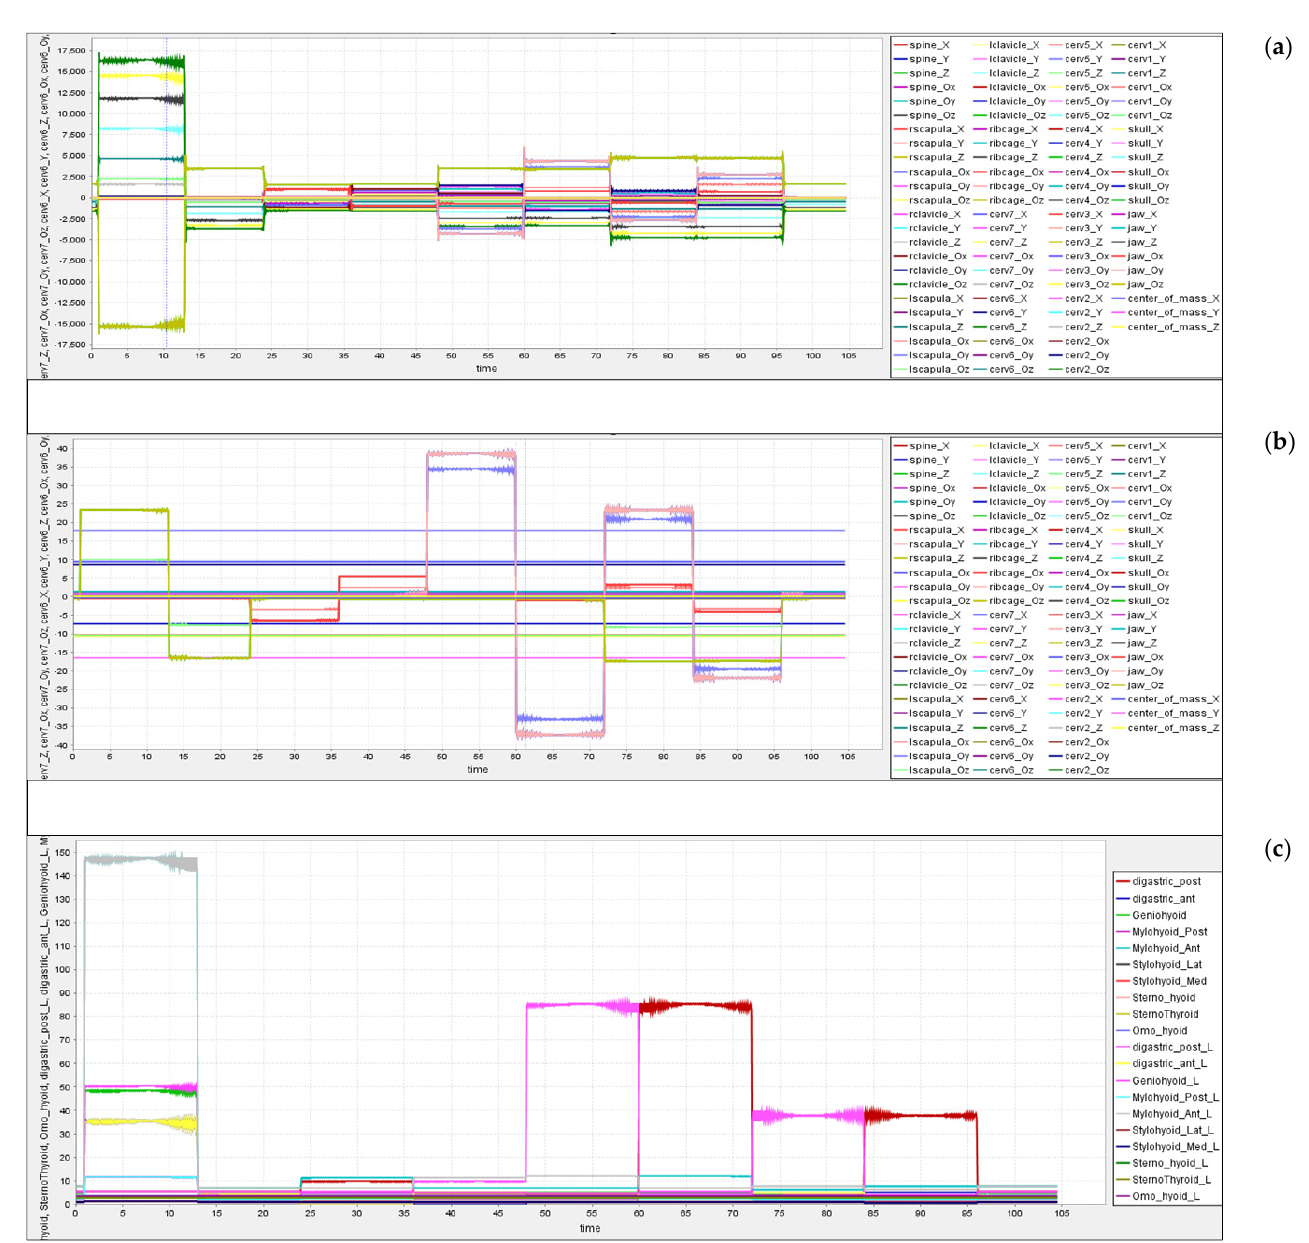
Figure 8. ( a ) Kinematics—neck acceleration; ( b ) kinematics—neck position; ( c ) kinetics—tendon forces.